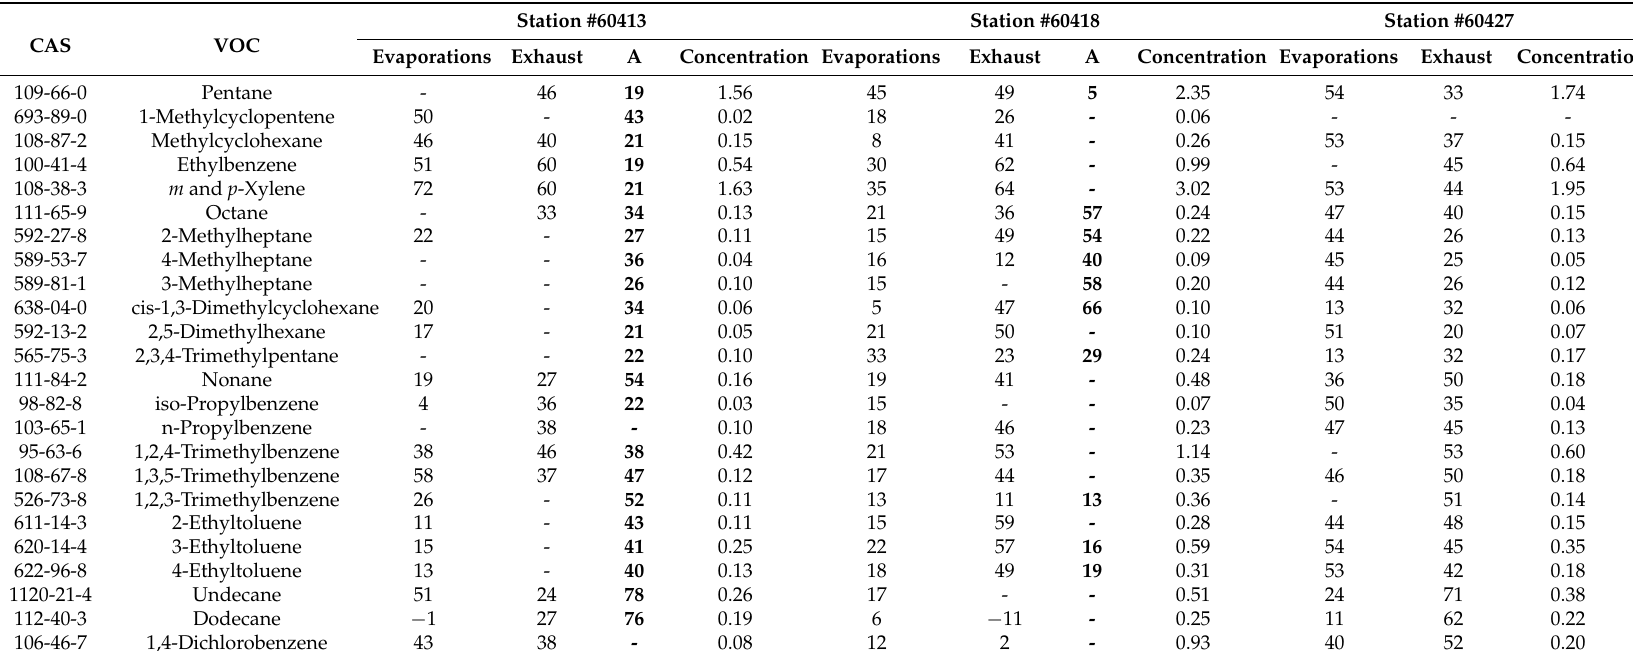
Table 6. Profiling point source A and the traffic background at three stations of increasing distance from the